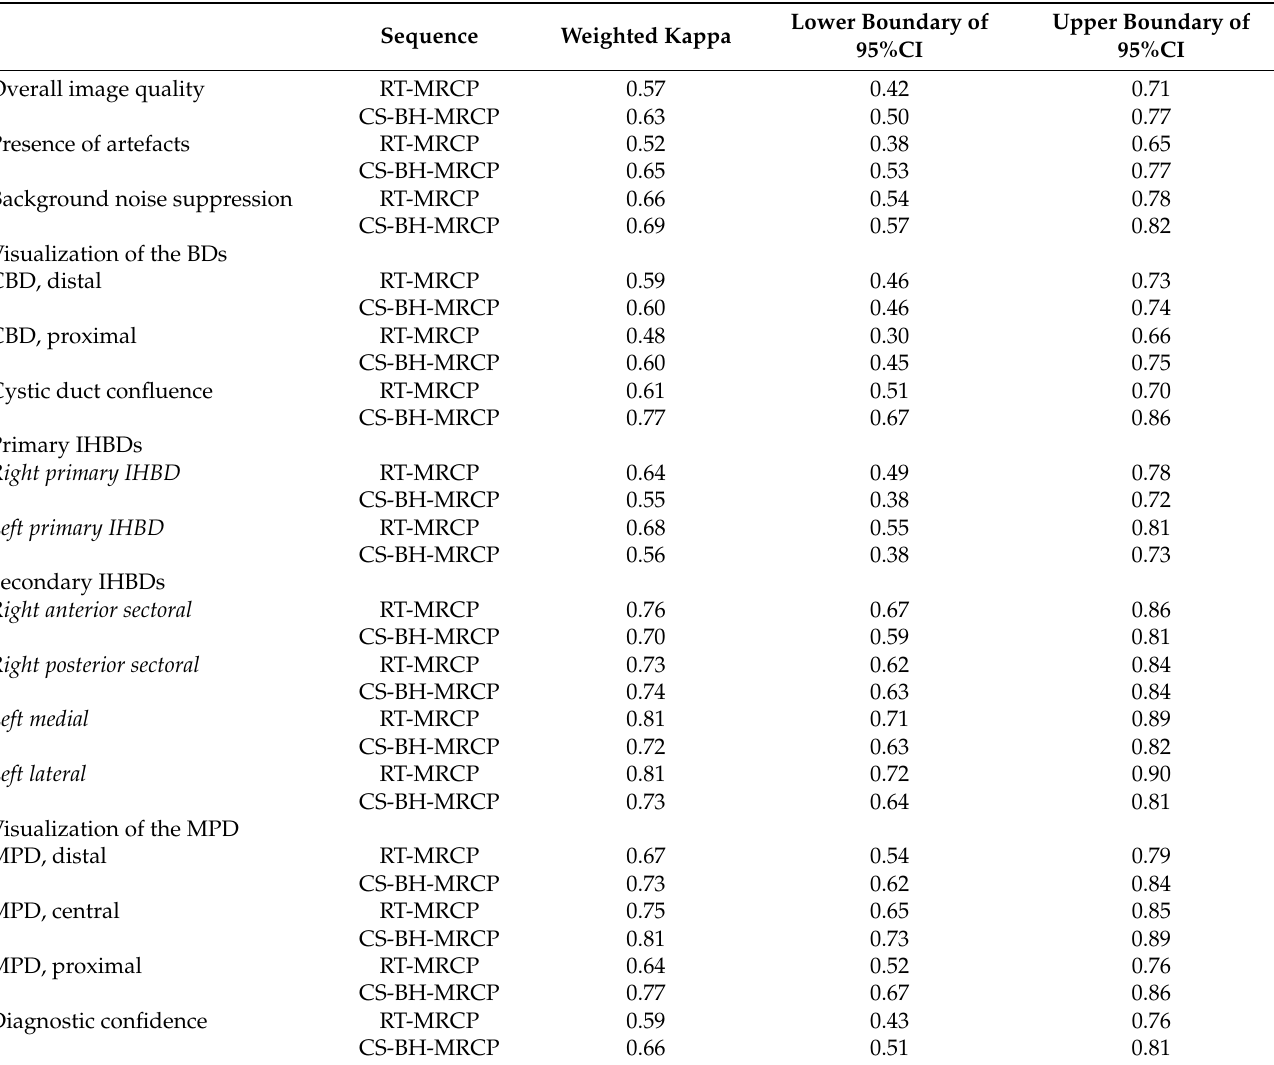
Table A3. Inter-observer agreement for image quality qualitative evaluation and diagnostic confidence between RT-MRCP and CS-BH-MRCP sequences.